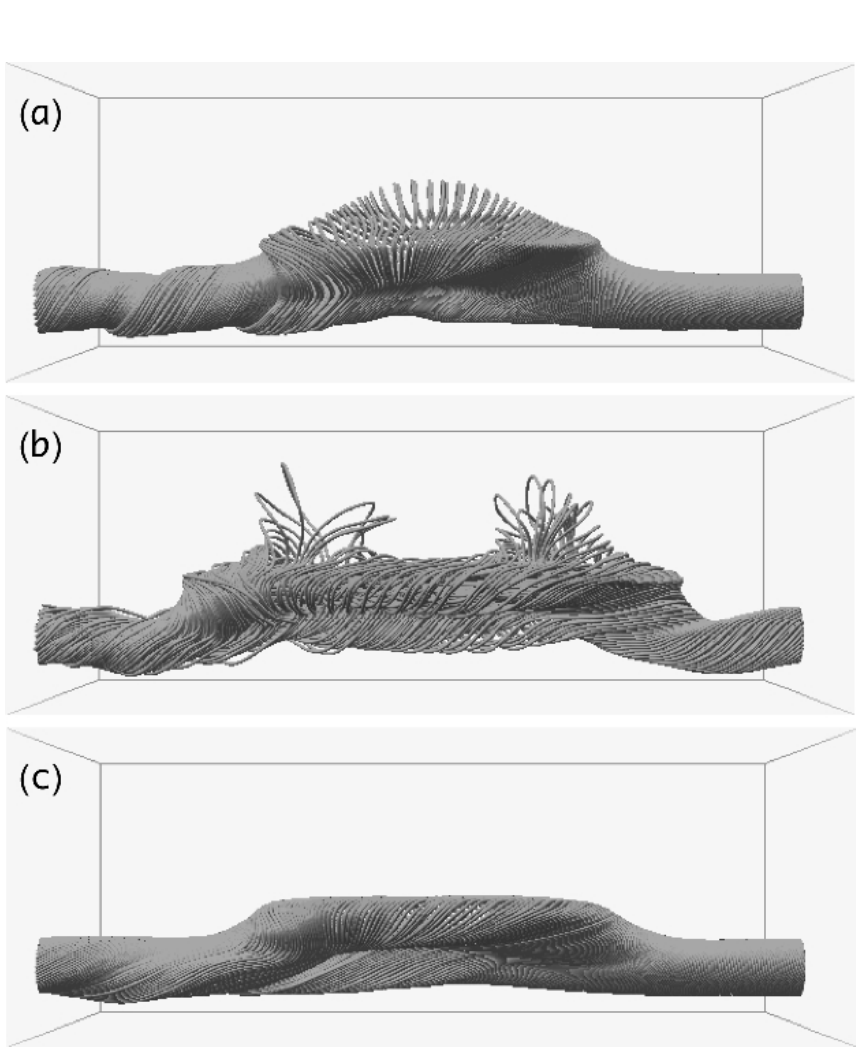
Figure 23: Traces of magnetic field lines in three separate numerical experiments of twisted flux tube emergence. Panels (a)–(c) show simulations with an initial twist parameters of 𝑞 = 0 . 3, 𝑞 = 0 . 2, and 𝑞 = 0 . 1, respectively. The radius initial radius of the tube in these experiments is 𝑎 = 2 . 5 (see Eqs. (40) and (41)). Image reproduced with permission from Murray et al. (2006), copyright by